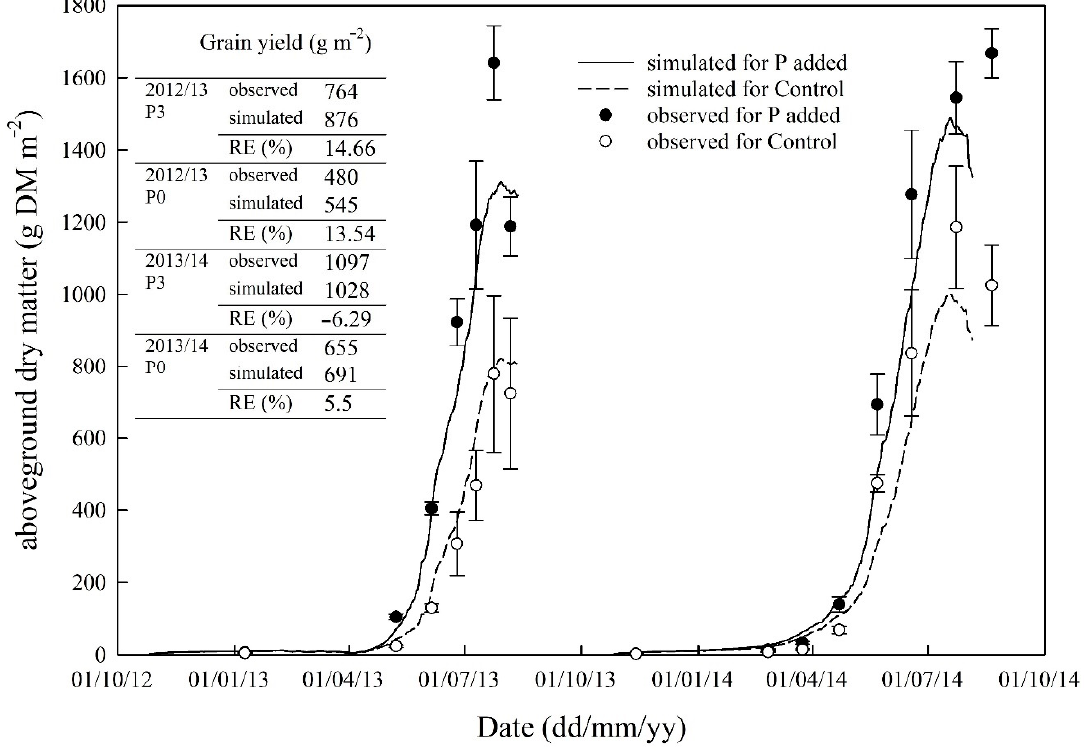
Figure 3. Simulated and observed (three replications) aboveground dry matter accumulation and leaf weight over two growing seasons. The error bars represent the standard deviation.